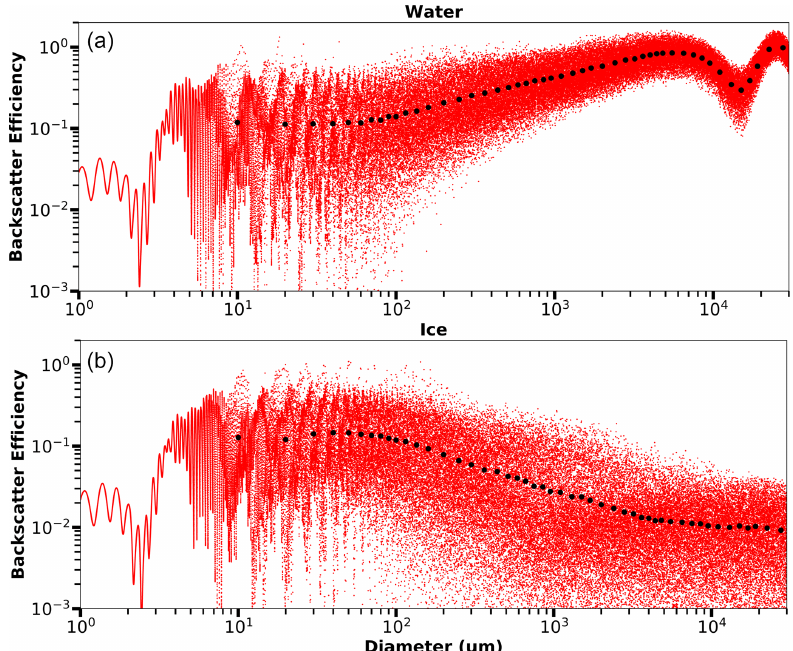
Figure 3. Plots showing backscatter efficiencies using Mie theory for spherical water (a) and ice (b) particles. The MiePlot software package (Laven, 2020) is used to calculate efficiencies for 100000 particle diameters distributed log-normally between 1µm and 30mm (red dots). Intervals between diameters used for the individual backscatter efficiency calculations range from 0.0001µm at the lowest diameters to 3µm at the highest diameters. Black circles are average efficiencies over the combined spectrum channel widths (see Table 1 for numerical values). A refractive index of 1 . 3263 + 5 . 6 × 10 − 7 i is used for water (Kedenburg et al. 2012) and 1 . 3031 + 5 . 6 × 10 − 7 i for ice (Warren and Brandt, 2008). Scattering is for an air medium at 20 ◦ C and incident light of